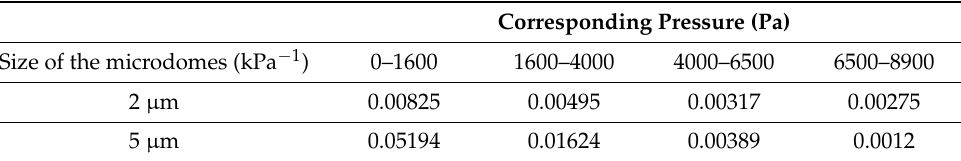
Table 3. Experimental sensitivity values of the pressure